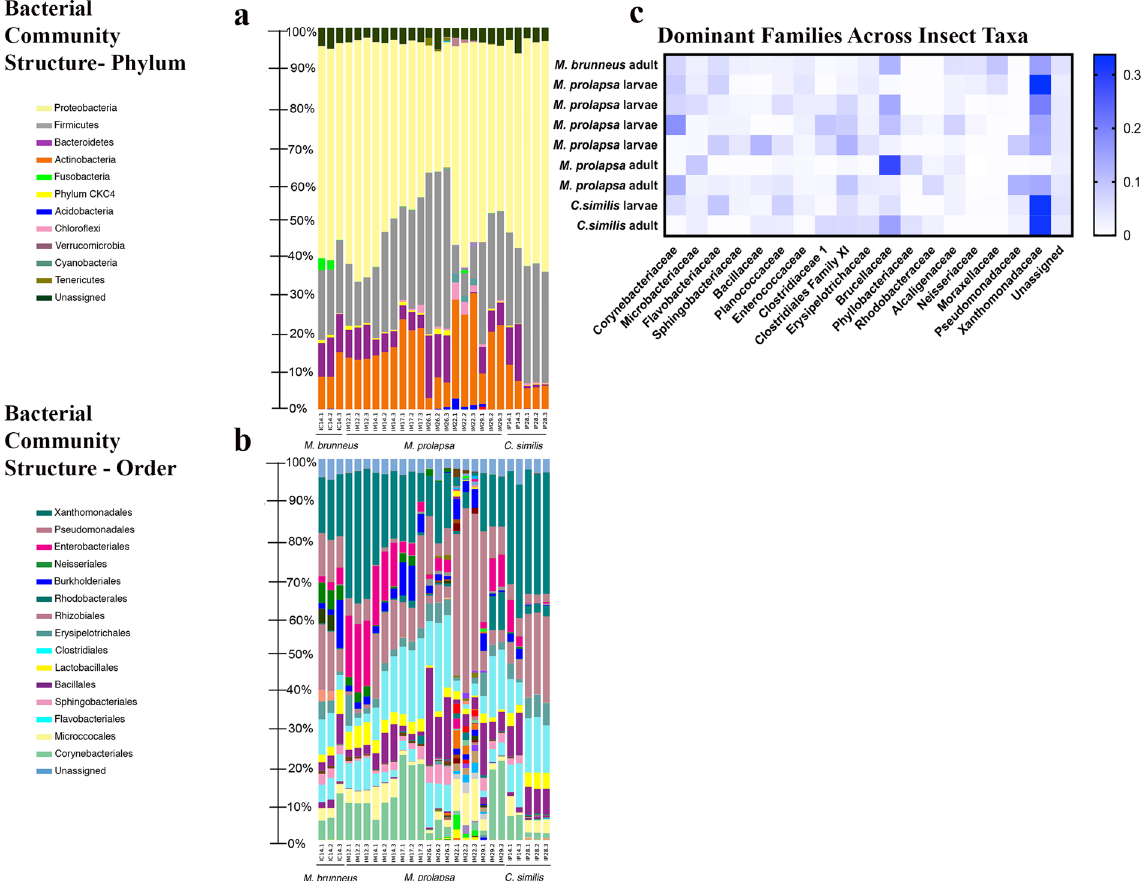
Figure 5. Bacterial community composition for insect-associated samples. ( a ) Phylum; ( b ) Order; ( c ) Family (Staphylinidae: M . brunneus ; Muscidae: M . prolapsa ; Phoridae: C . similis